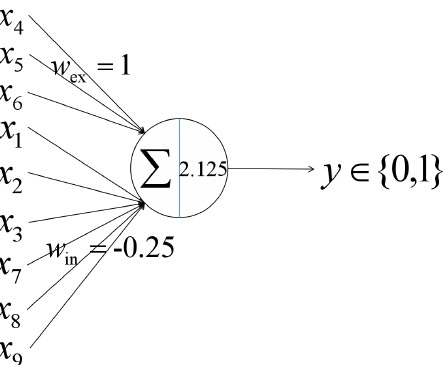
Figure 2. An example of given value of weight and bias.